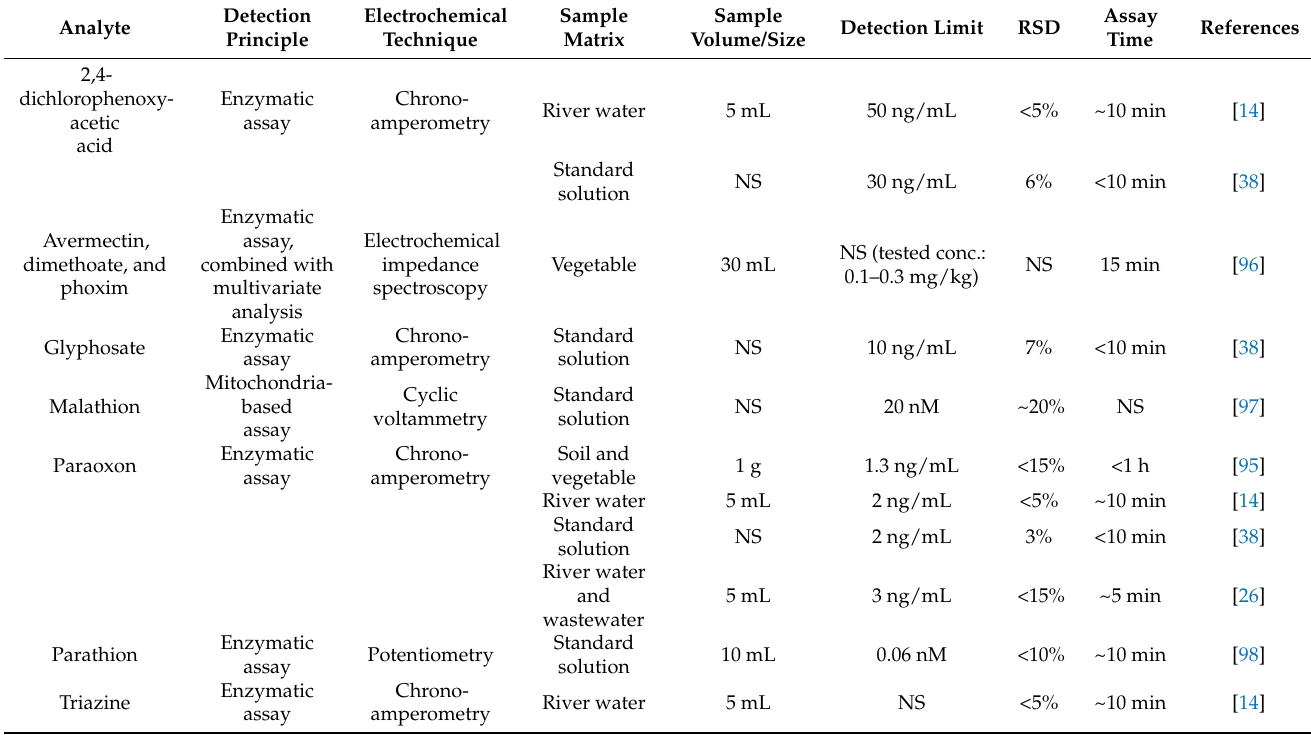
Table 4. Detection of pesticide residues in